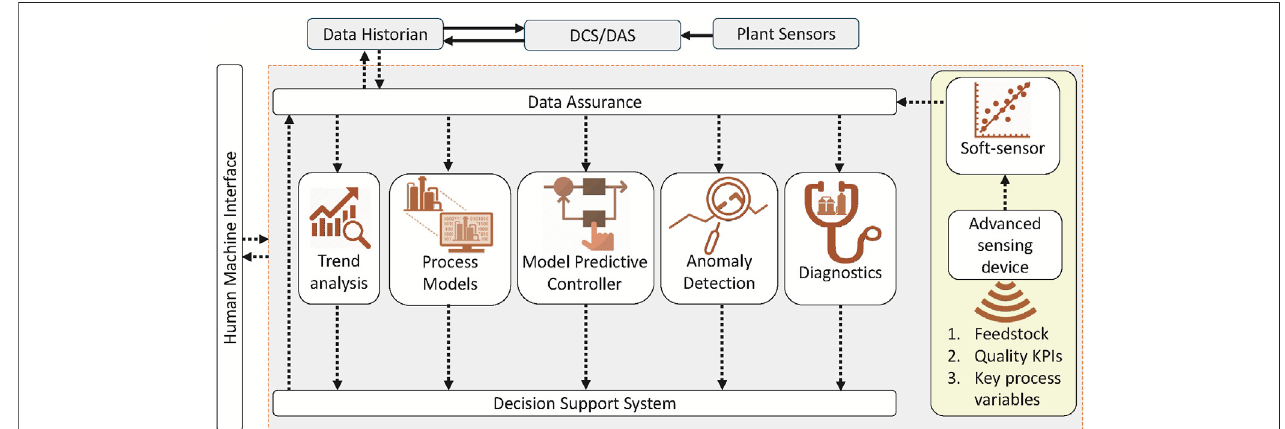
FIGURE 3 | Learning system architecture (Rahman et al.,